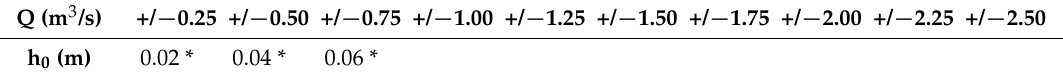
Table 2. Discharge (Q) and initial water level (h 0 ) variants for the hybrid modelling.